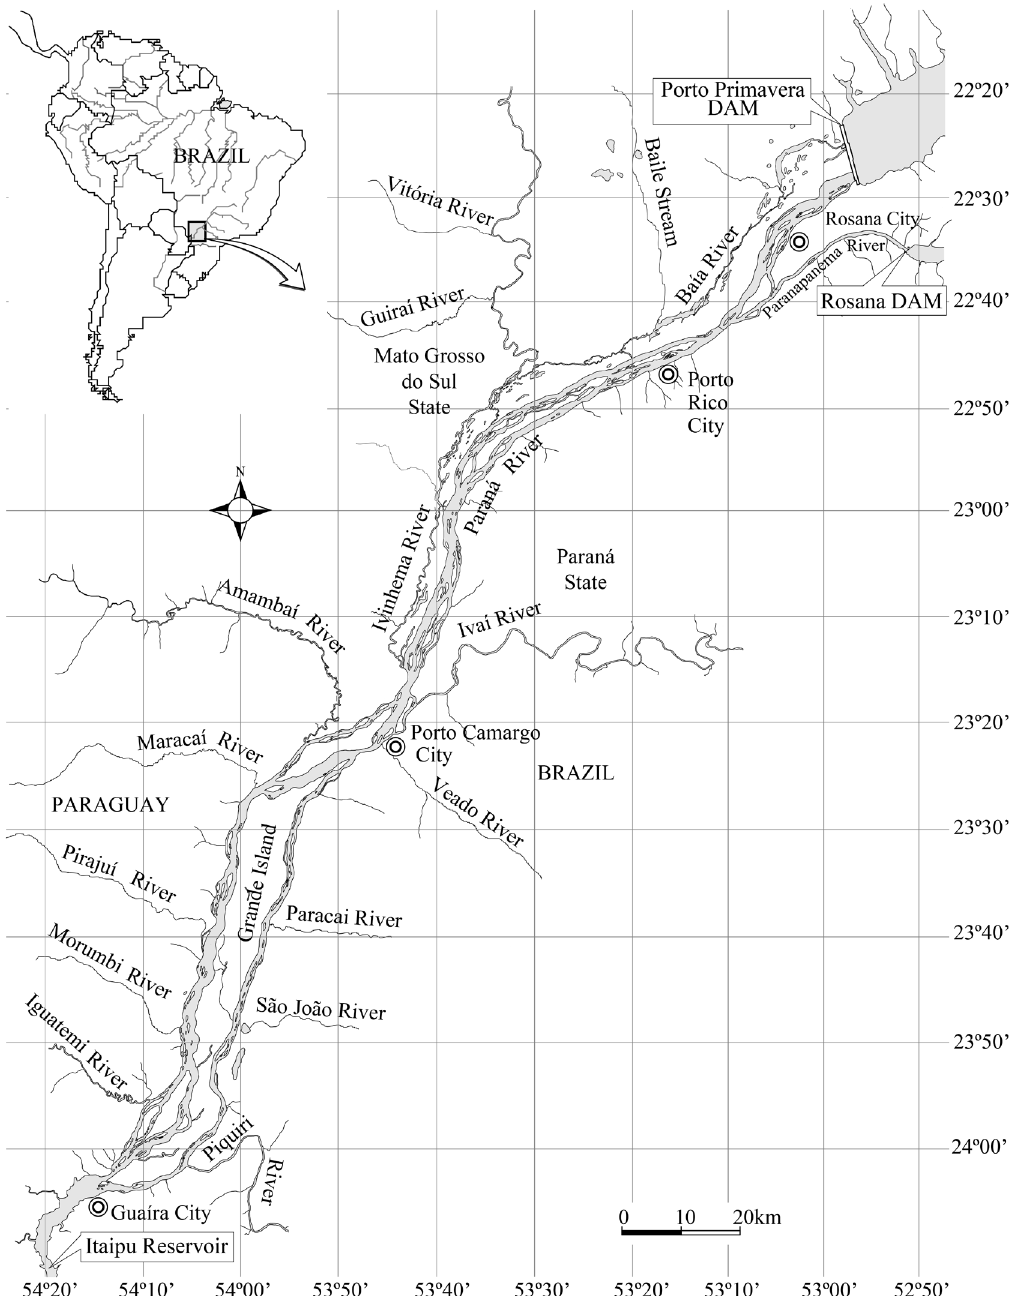
Figure 1. Map showing the upper Paraná River